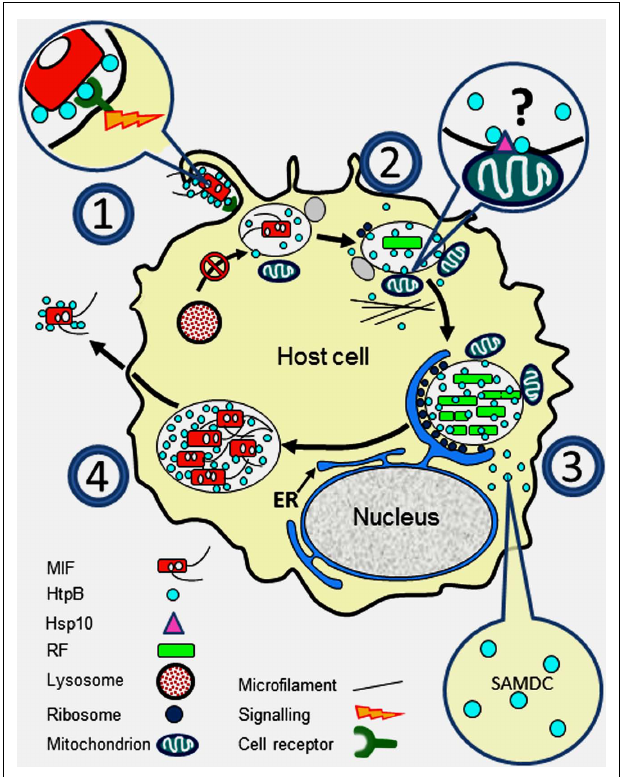
FIGURE 1 | Surface exposed or released HtpB accompanies L. pneumophila along its growth cycle in host cells. (1) Extracellular L. pneumophila upregulates expression of HtpB in the presence of host cells (see Links Between HtpB and L. pneumophila Virulence), and the interaction of surface-exposed HtpB with cell receptors (Inset 1) triggers a signal leading to internalization (see Surface-Exposed HtpB Acts as an Invasion Factor). (2) Internalized legionellae associate with ER-derived vesicles, attracts mitochondria, and inhibit fusion with lysosomes. HtpB bound to beads is sufficient to mimic the last two events (see Surface-Exposed HtpB Alters OrganelleTraffic). HtpB reaches the cytoplasm of the host cell where it could alter the actin cytoskeleton (Inset 2).The mechanism by which HtpB attracts mitochondria is unknown, but alteration of actin fibers and tethering via mitochondrial Hsp10 could be involved (see HtpB in the Eukaryotic Cytoplasm has Several ProteinTargets). (3) During replication, released HtpB accumulates in the LCV from which it could reach the host cell cytoplasm (see Links Between HtpB and L. pneumophila Virulence and HtpB is Found in Extracytoplasmic Locations). Inset 3: HtpB in the cytoplasm of host cells (mammalian and amebal) interacts with SAMDC to potentially increase the intracellular pool of polyamines (see HtpB in the eukaryotic cytoplasm has several protein targets). (4) As L. pneumophila differentiates into MIFs, the amount of HtpB associated with the cell envelope and bacterial cell surface increases (see HtpB is Found in Extracytoplasmic Locations). As the LCV ruptures, large amounts of HtpB are likely released together with MIFs. Immunomodulatory effects (see Immunological Studies with HtpB) can be triggered by HtpB at any stage of the cycle. Key: ER, endoplasmic reticulum; RF, replicative form; MIF,